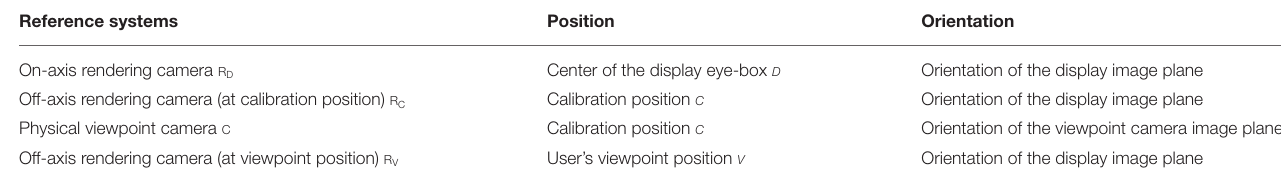
TABLE 1 | Position and orientation of all the reference systems involved in the OST perspective projection